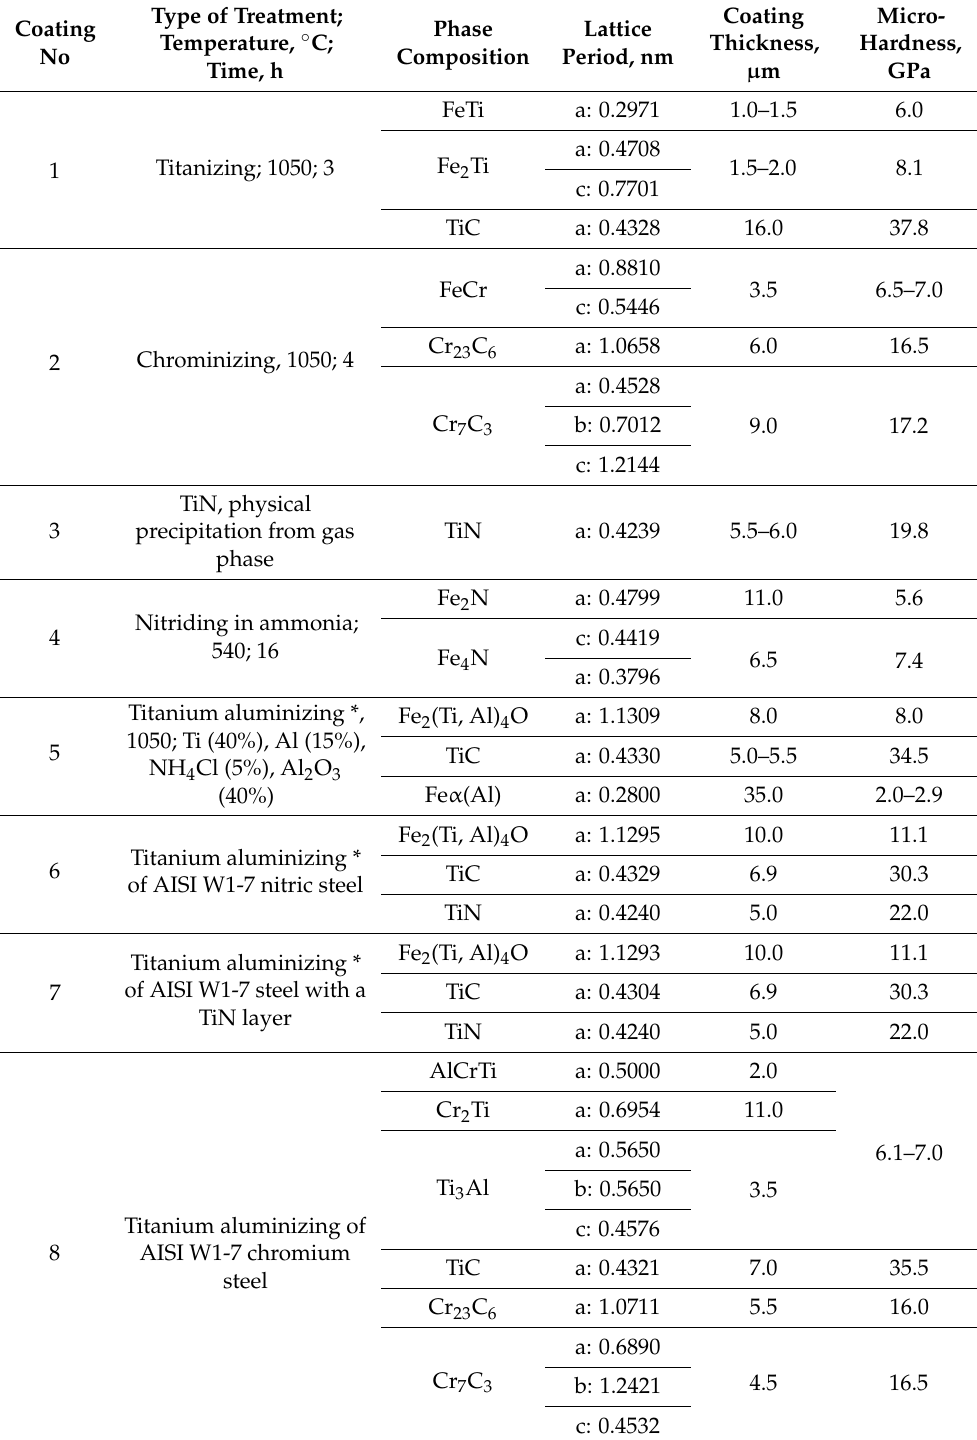
Table 3. The phase composition and coating characteristics of AISI W1-7 steel (compounds zone).